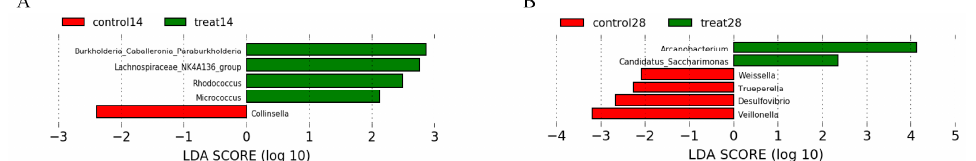
Figure 5. Effects of dietary supplementation with MSFAs on the rectal swab microbial diversity and compositions of sows at 14 and 28 days of gestation. Linear discriminant analysis coupled with effect size (Lefse) of day 14 ( A ) and day 28 ( B ) rectal swab microbiota compositions in the control and treated sows. Control14 (28), day 14 (28) of gestation and fed the basal diet. Treat14 (28), day 14 (28) of gestation and fed a basal diet supplemented with 0.1 SB, 0.05 SC and 0.1% SL.